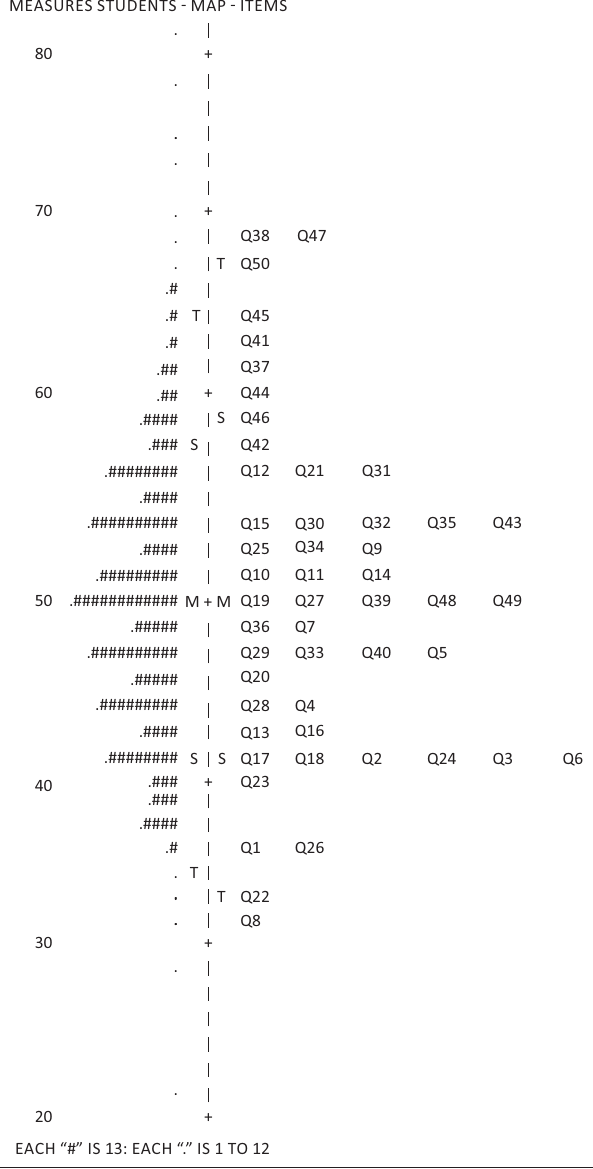
Figure 6a and Figure 6b present a percentage-based PrimTEd mathematics report for first-year students from two universities, University A and University B. The information presented in the report comprises: (1) sample size, mean scores and standard deviations, (2) students’ score distributions by deciles, (3) student mean scores by content domain and (4) student mean scores by cognitive demand and pedagogy categories. The results of the independent sample t-test reveal that the mean scores of students in University B are significantly